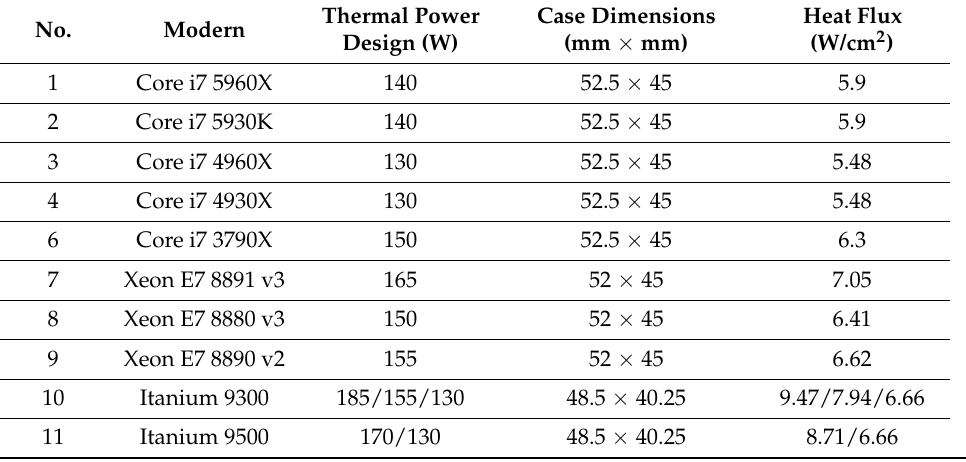
Table 2. Different LHP technologies from the literature.